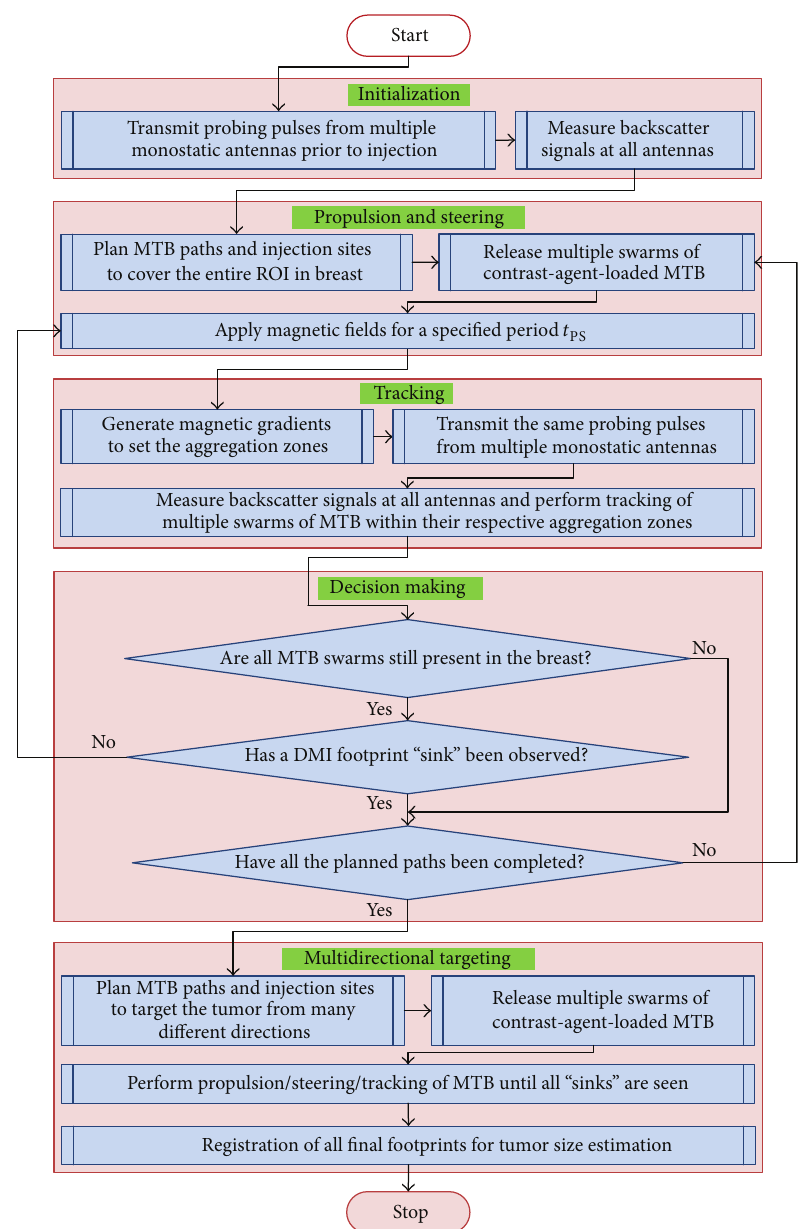
Figure 4: Flowchart representing the system architecture of breast tumor detection and diagnosis with multiswarm MTB